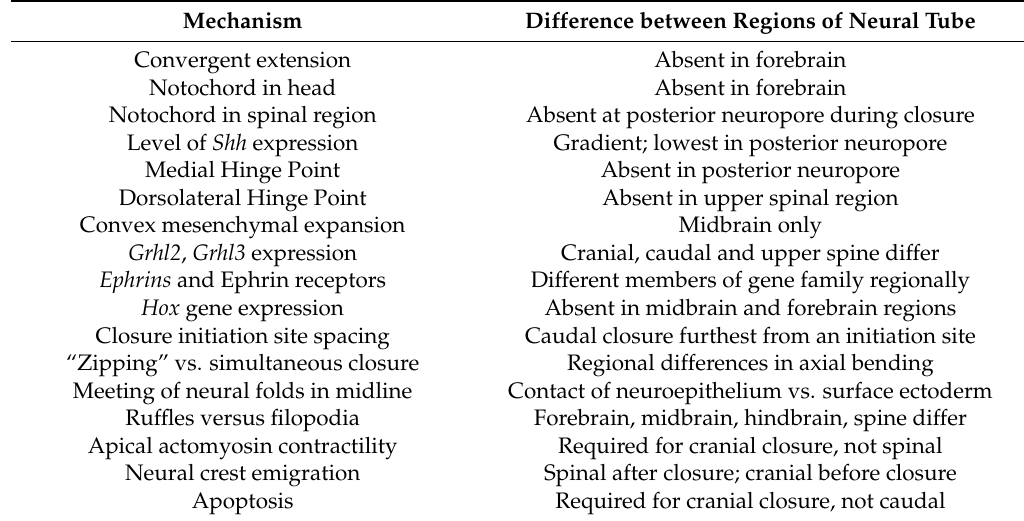
Table 2. Regional differences in mechanisms for neural tube